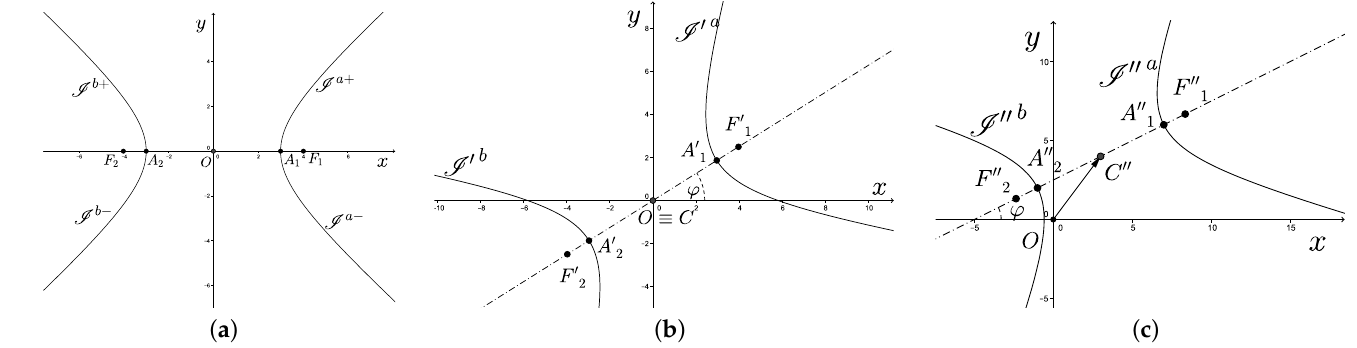
Figure A1. ( a ) Hyperbola in the canonical reference frame and ( b ) after rotation by an angle ϕ . ( c ) Hyperbola after